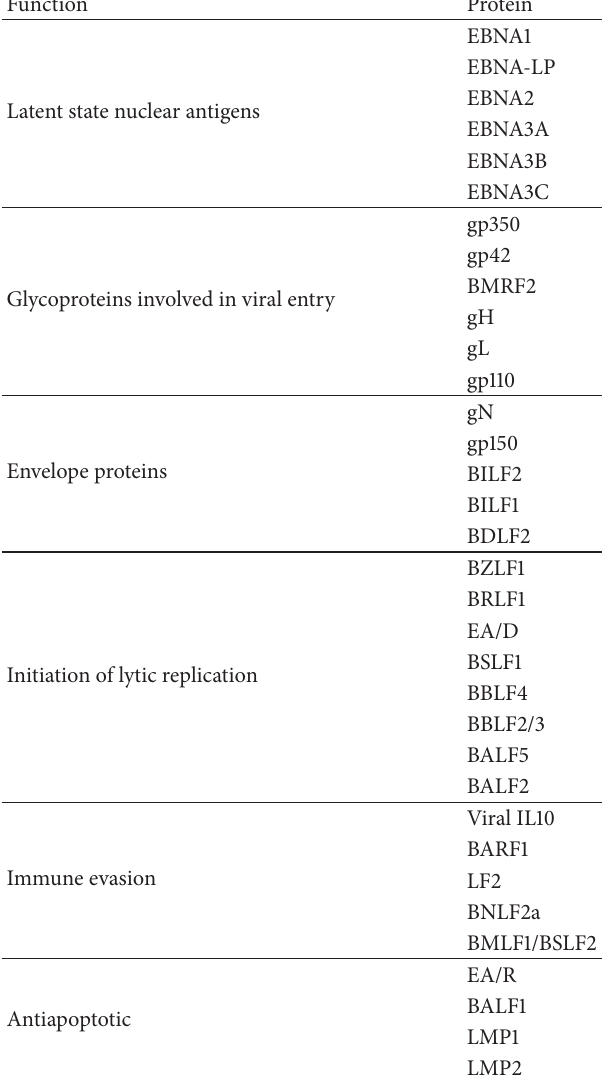
(Table 2): the viral DNA polymerase (BALF5), the viral